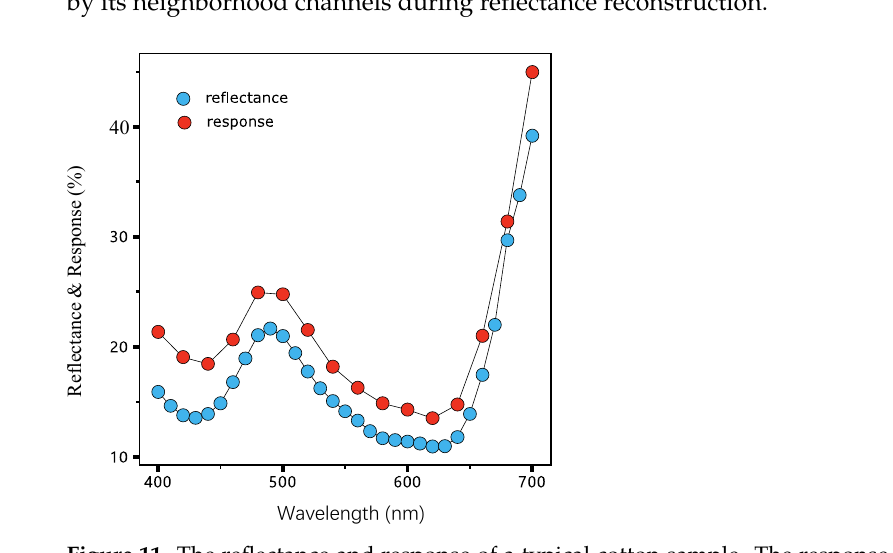
Figure 11. The reflectance and response of a typical cotton sample. The response is a 16-d vector measured by a self-made MIS and reflectance is a 31-d vector measured by a